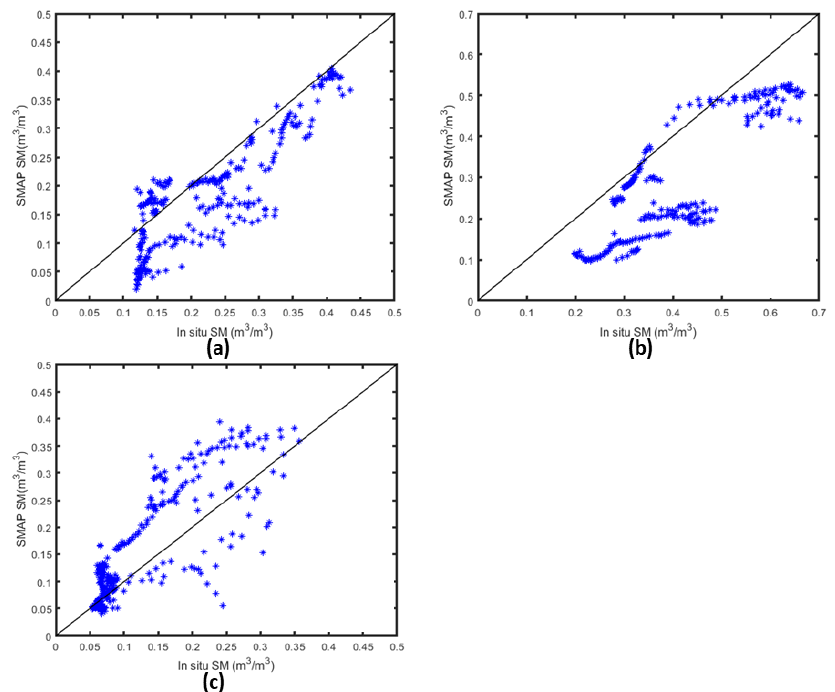
Figure 7. Comparisons between the SMAP SM and in situ SM for ( a ) Varanasi, Uttar Pradesh ( b ) Hoshangabad, Madhya Pradesh and ( c ) Anand, Gujarat, India, Asia. Table 5. Results of comparison between the in situ and SMAP data set at selected sites in India (Asia). Statistical Test Varanasi Hoshangabad